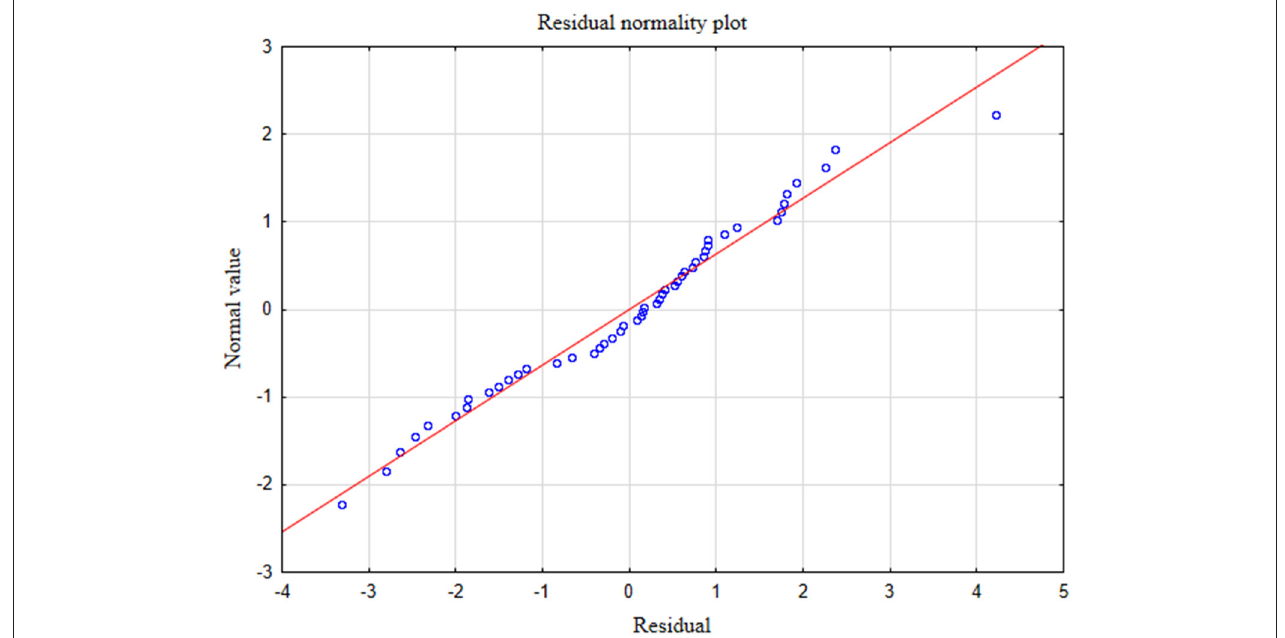
FIGURE 2 | Normality of the distribution of residuals with respect to multiple linear regression model for PHQ-9